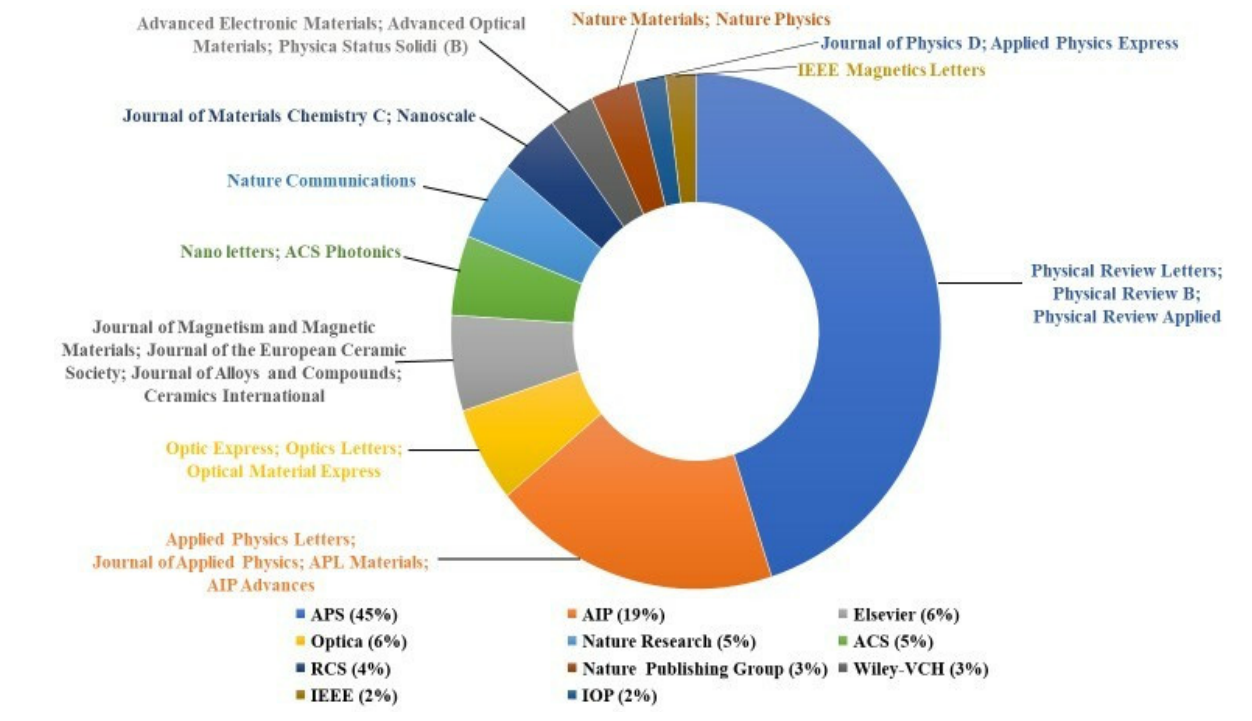
Figure 9. Publishers of the top articles.